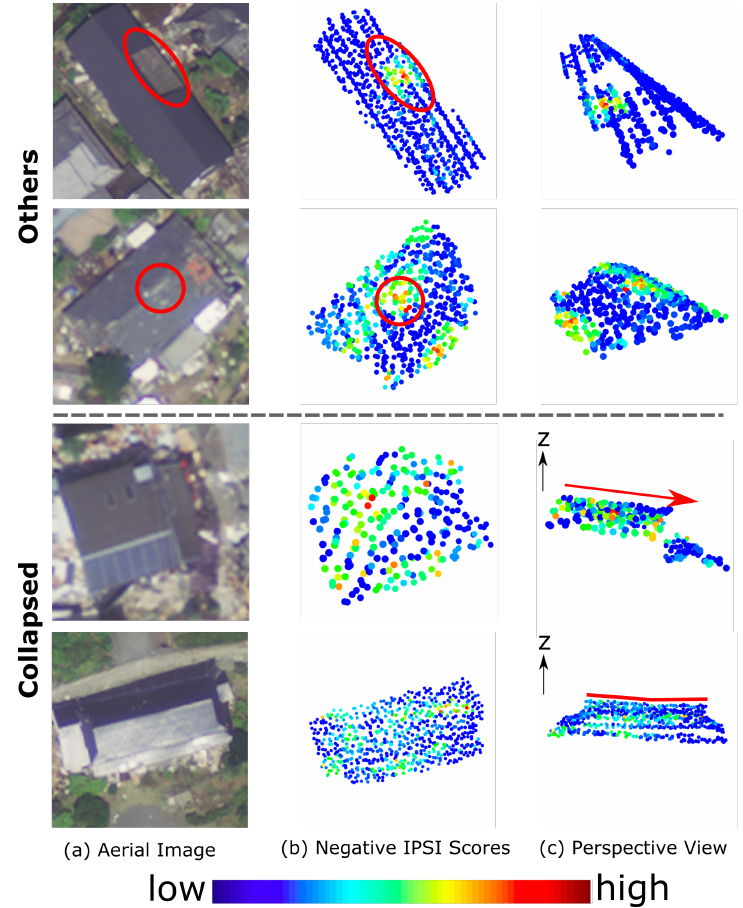
Figure 10. Examples of misclassifications when using building roofs. Buildings in the first two rows belong to the “others” class, but were misclassified as “collapsed”, whereas buildings in the last two rows belong to “collapsed”, but were misclassified as “others”. ( a ) shows the aerial image [12]; ( b ) shows negative IPSI scores (roof); and ( c ) shows the perspective views, from which the causes of misclassification can be clearly